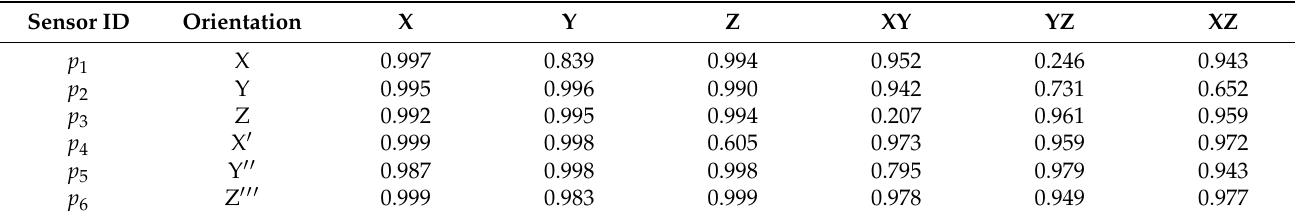
Table 2. R 2 index of the sensitivity matrix coefficients of Table 1.